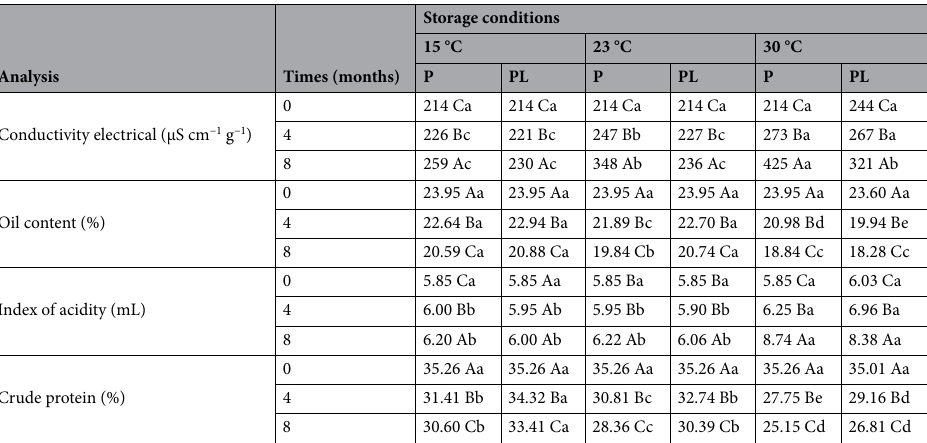
Table 8. Quality of soybeans harvest at 18% (d.b.) moisture content subjected to drying at 80, 100 and 120 °C, stored in different environments and packaging for eight months. Means followed by the capital letter in the column for each time of storage and lower lines for each temperature of storage. do not differ at 1 and 5% probability. PL—polyethylene plastic bag. P—paper bag.